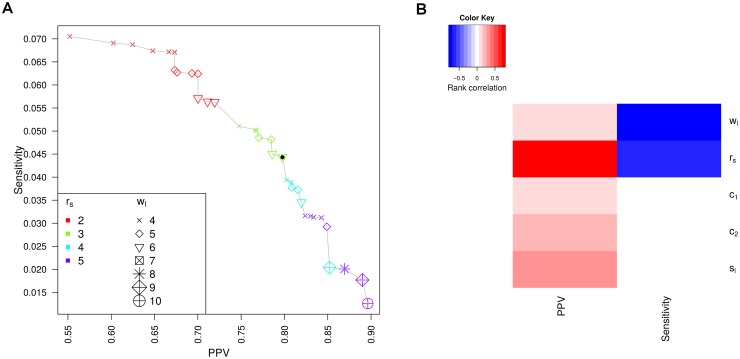
Parameter training results.(A) Comparison of PPV and sensitivity for evaluated parameters. Results are only shown for parameter combinations for which no other combination has a higher PPV at the same or higher sensitivity or a higher sensitivity at the same or higher PPV (i.e. locally “optimal” parameter combinations). Results for the default parameter choice are indicated by a filled black circle. Colors and symbols indicate the values for rs (minimum number of poly(A) reads required) and wl (window length), respectively. (B) Heatmap illustrating the (spearman) rank correlation between PPV and sensitivity for each parameter across all evaluated parameter combinations.